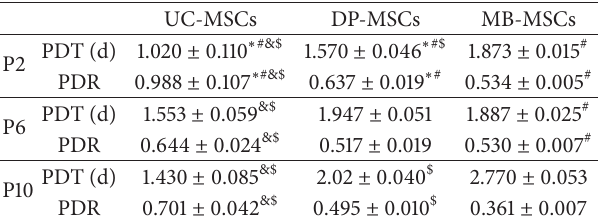
Table 2: Cell population doubling for UC-MSCs, DP-MSCs, and